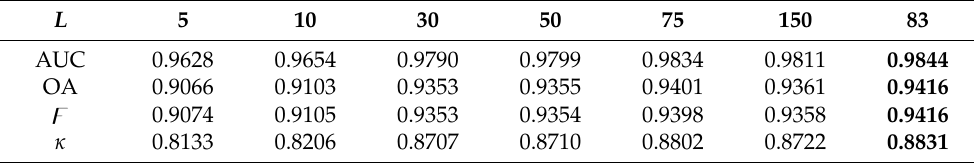
Table 4. The quantitative comparison for AUC, OA, F-score (denoted (cid:122) ), and Kappa coefficient (denoted κ ) with different L s for the YC Lake data. Bold numbers indicate the highest values in each